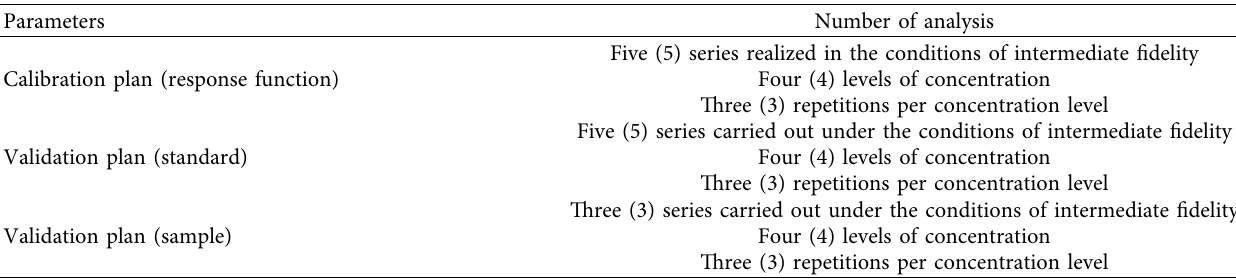
Table 3: Validation plan.